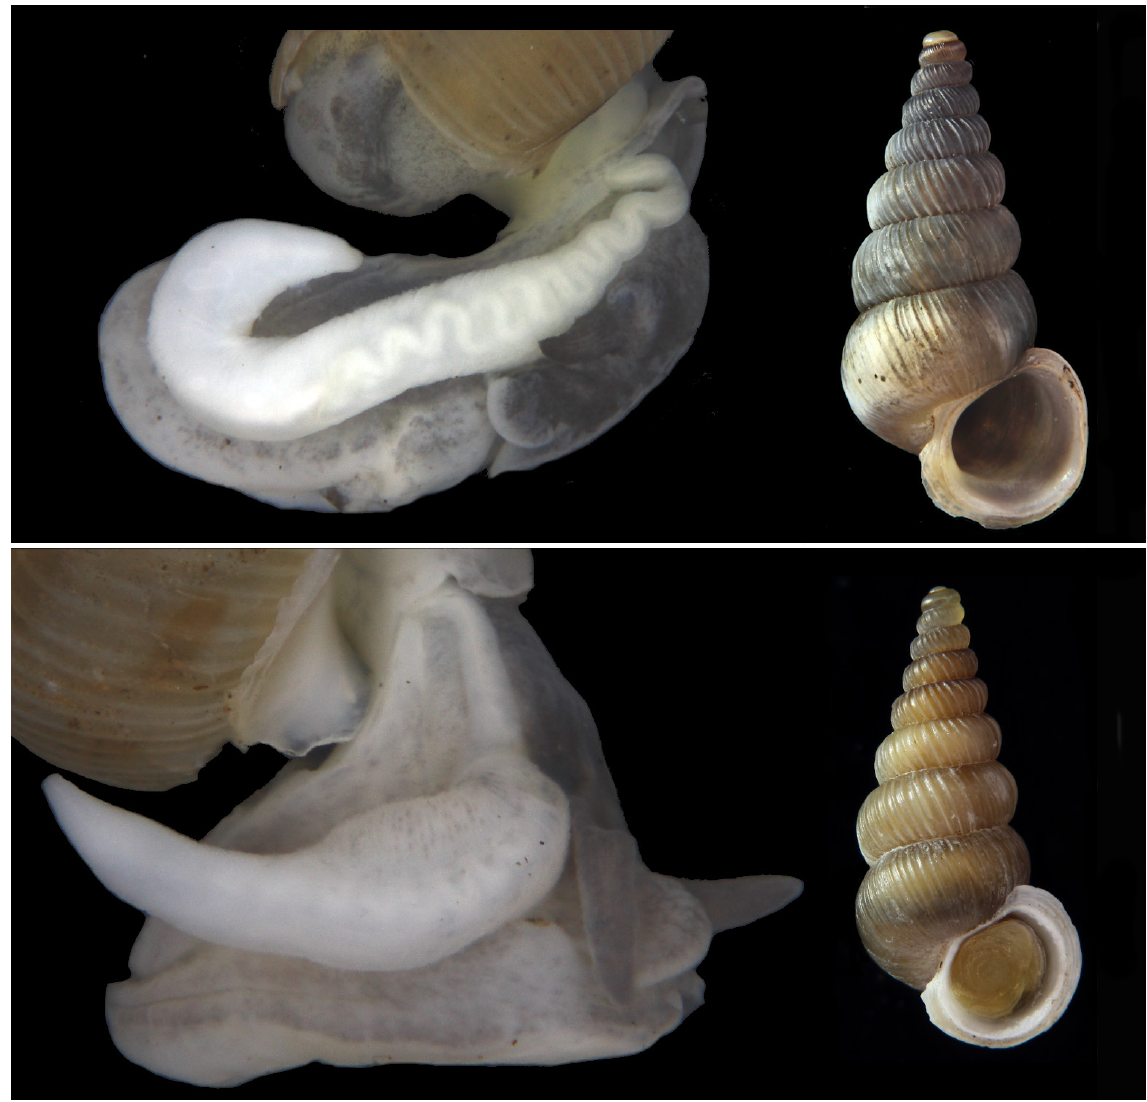
Fig. 35. Example of two populations of species of Clessiniella Zallot et al ., 2015 which are impossible to distinguish without analyzing the male genitals. Male shells. Top: Cochlostoma ( Clessiniella ) waldemari (A.J. Wagner, 1897), Mt Klek, Croatia (EZ0904). Bottom: Co. ( Cl. ) tergestinum (Westerlund, 1878), Val Rosandra, Italy